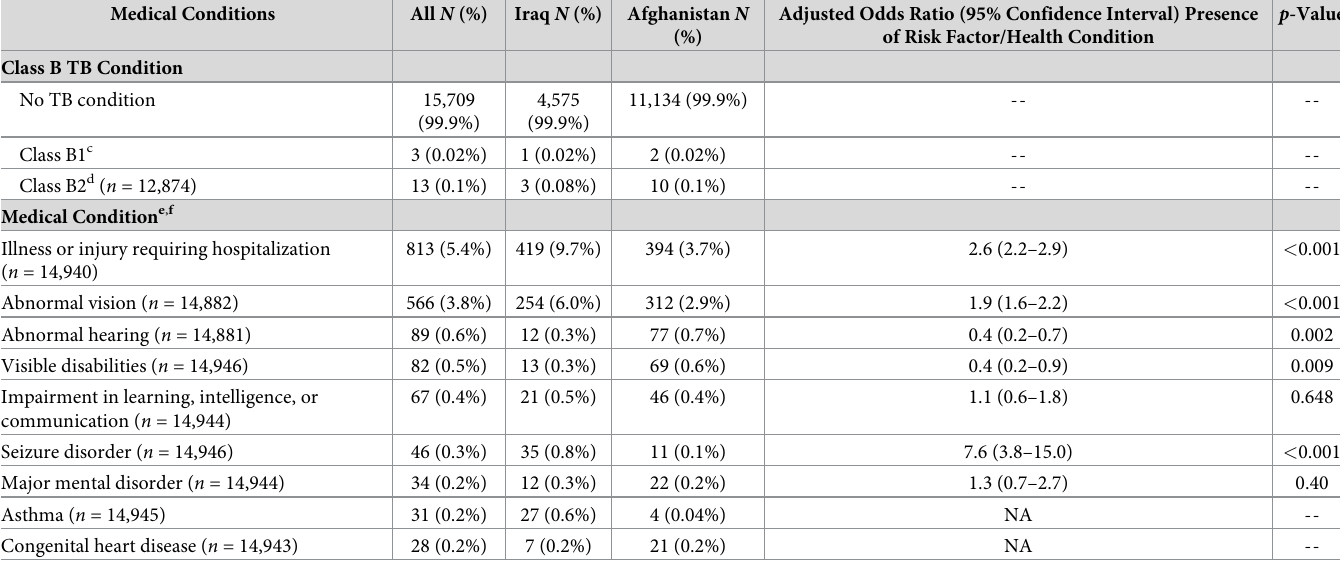
Table 2. Prevalence of admissible (Class B) tuberculosis (TB) conditions and other medical conditions among SIVH children less than 18 years of age resettling to the US, 2009–2017 ( n = 15,729) a,b . Medical